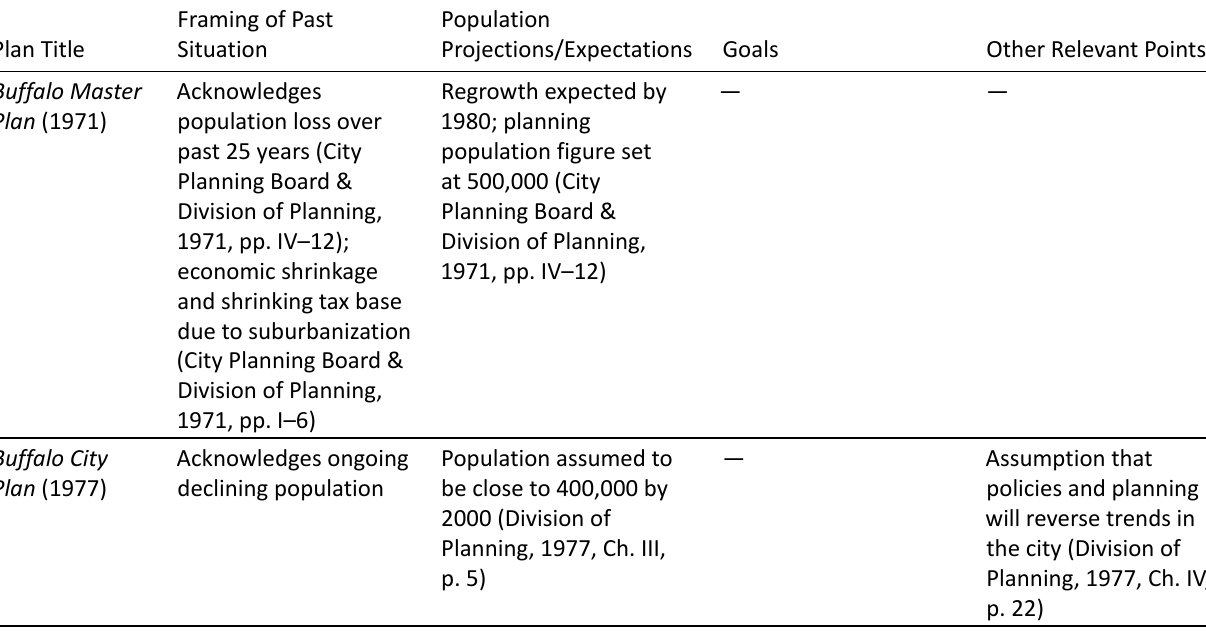
Table 2. Approaches to urban shrinkage as seen in municipal planning documents from Buffalo and